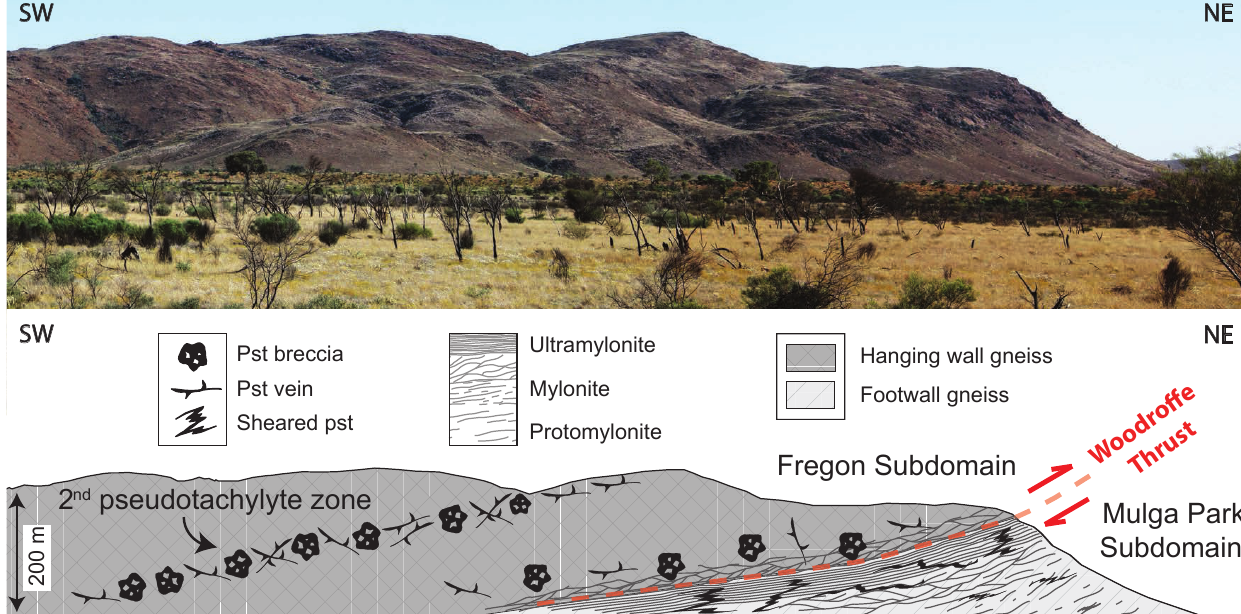
Figure 2. Photograph and schematic sketch of a cross section through the Woodroffe Thrust at Kelly Hills. Ductile deformation is almost entirely concentrated in the immediate footwall (Mulga Park Subdomain), developing a sequence of protomylonites, mylonites, and ultra- mylonites, with the degree of mylonitization decreasing into the footwall. In contrast, the mostly unaffected or only weakly foliated hanging wall (Fregon Subdomain) is characterized by ubiquitous and voluminous pseudotachylyte (pst) veins and breccias. Further into the hanging wall, a dip slope, characterized by a second zone of highly abundant unsheared pseudotachylyte, has also been documented. Photograph coordinates: 131.45077, −